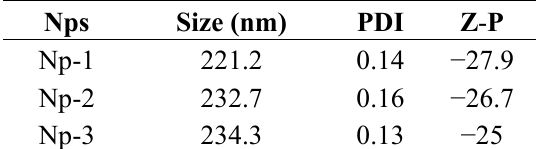
Table 2. Size distribution and zeta-potential of blank particles Np1 – 3